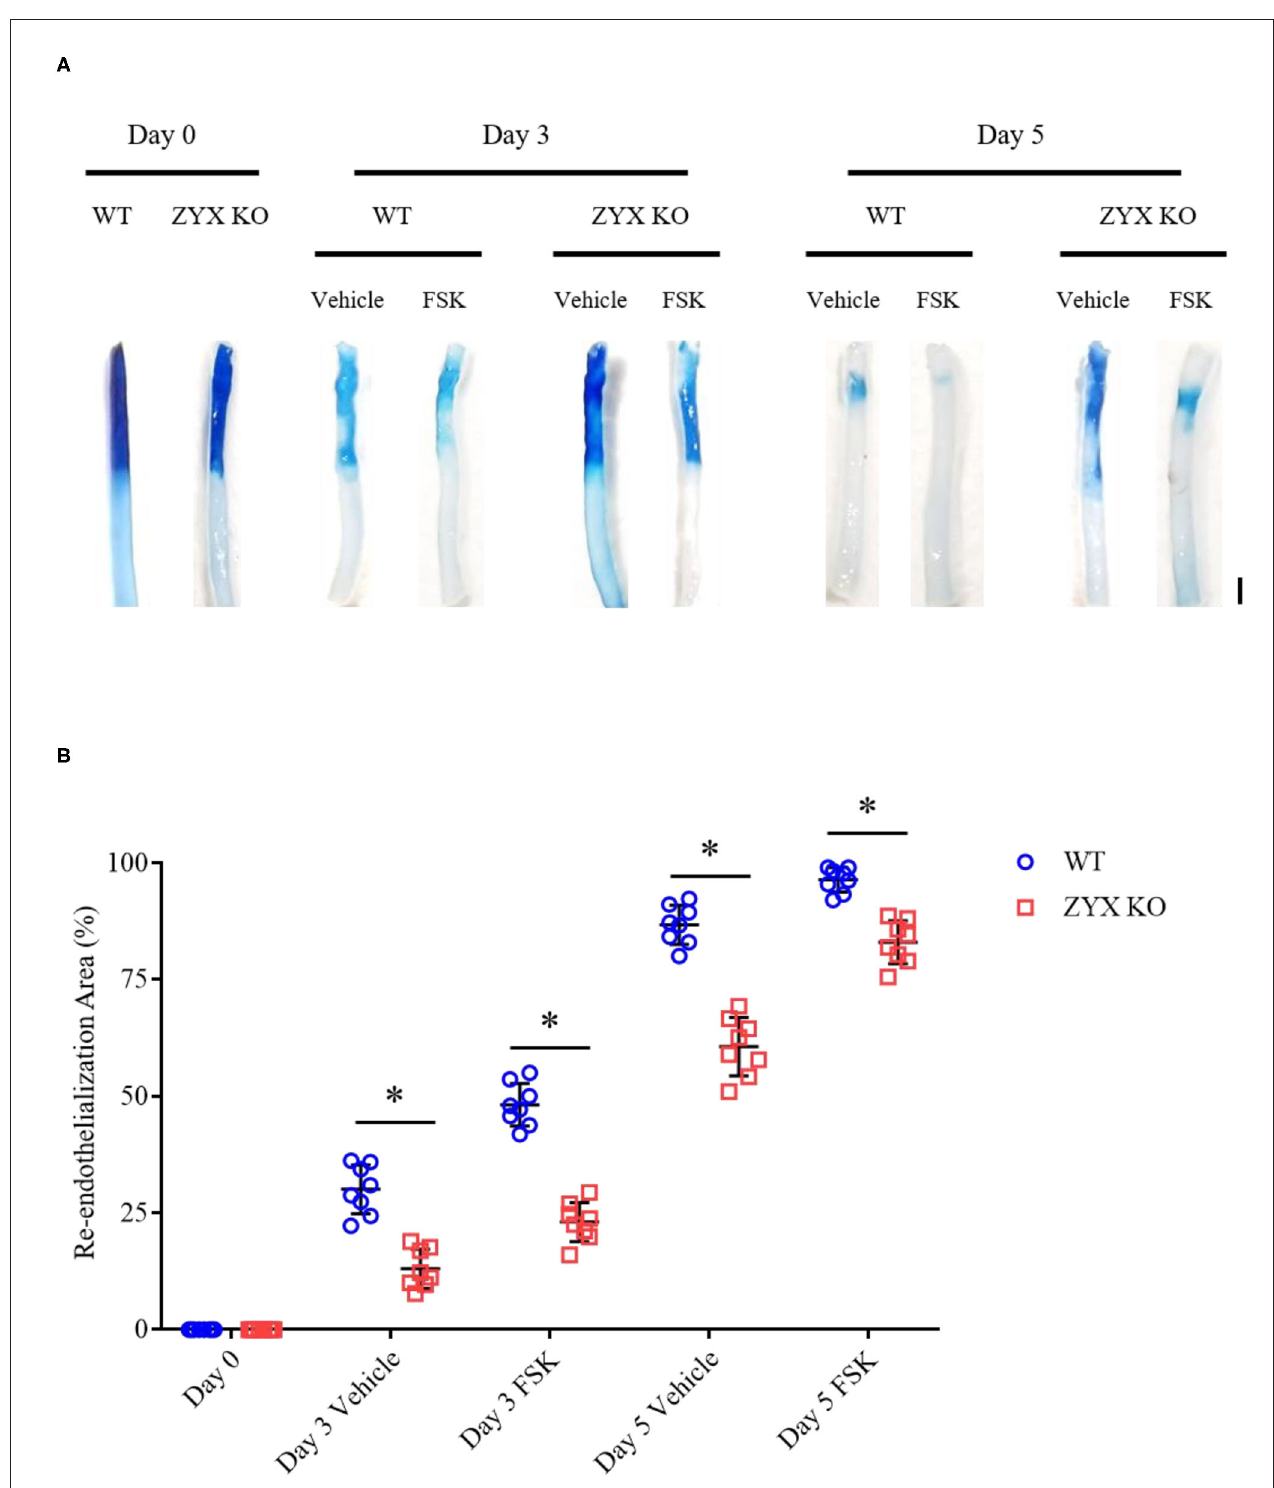
FIGURE 8 | Zyxin deficiency compromises re-endothelialization in injured arteries under forskolin stimulation. (A) Representative images of endothelial denudation assessed by Evans blue staining of carotid arteries 0, 3, and 5 days after injury with forskolin (FSK: 10mg kg − 1 , daily injection) or vehicle treatment (scale bar, 1mm). (B) Quantification of the re-endothelialization area after injury. Mean ± SD, n = 8, * P < 0.05. Test of normality: P > 0.05, test of homogeneity: P > 0.05. WT, wild-type; ZYX KO, zyxin knockout.